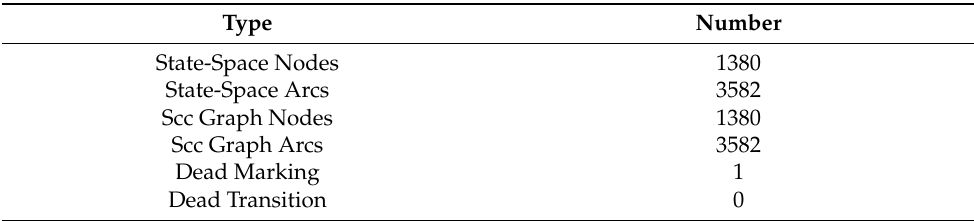
Table 4. State-space analysis of EnOcean protocol